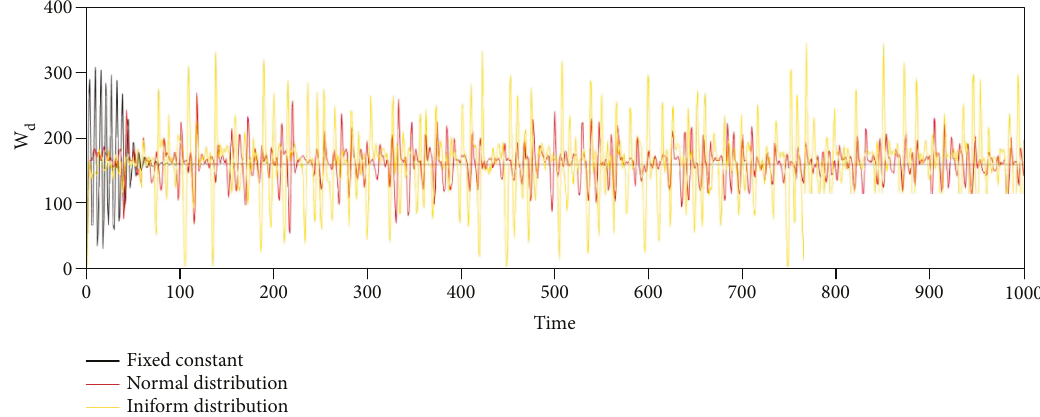
Figure 11: Change in tra ffi c volume of third-party logistics service providers in a stable state under three demand scenarios.